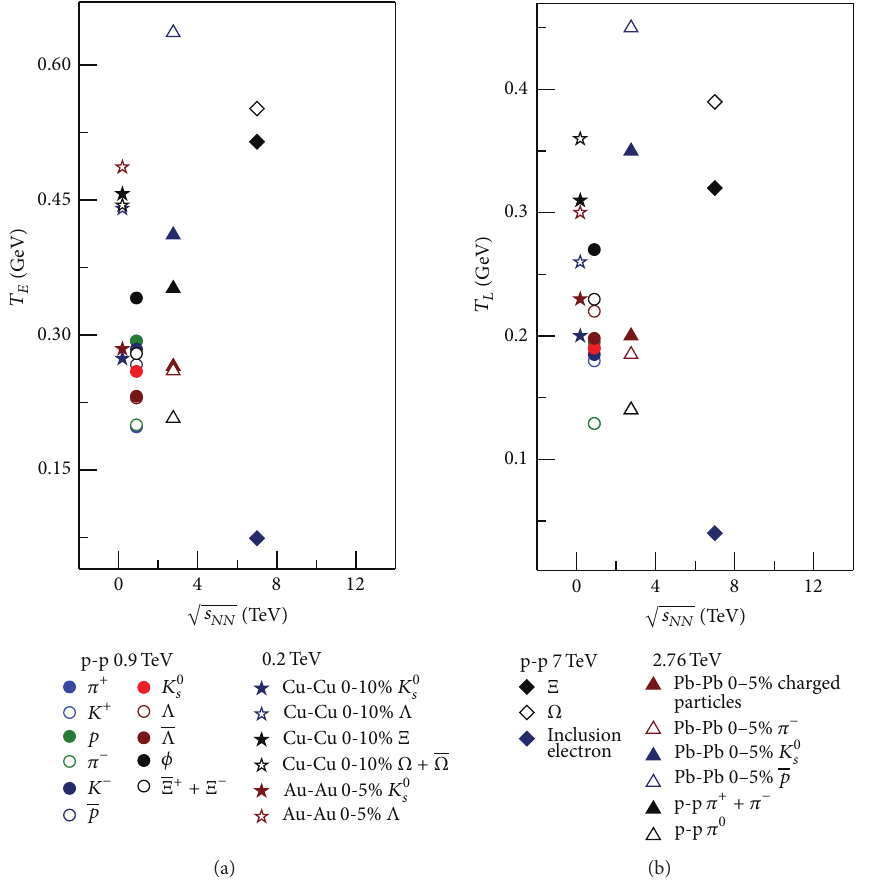
Figure 12: Dependences of temperatures 𝑇 𝐸 and 𝑇 𝐿 on √𝑠 𝑁𝑁